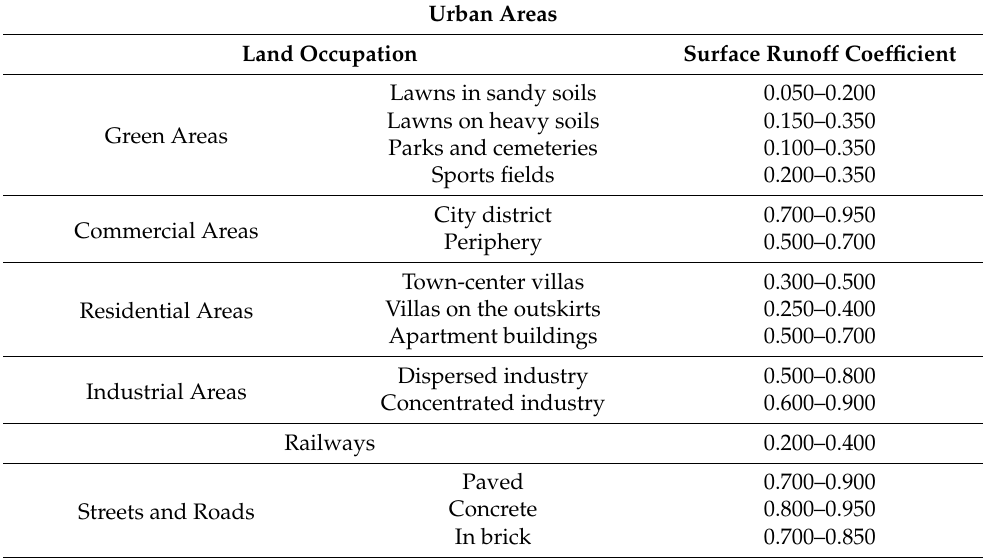
Table A2. Surface runoff coefficients (Source: